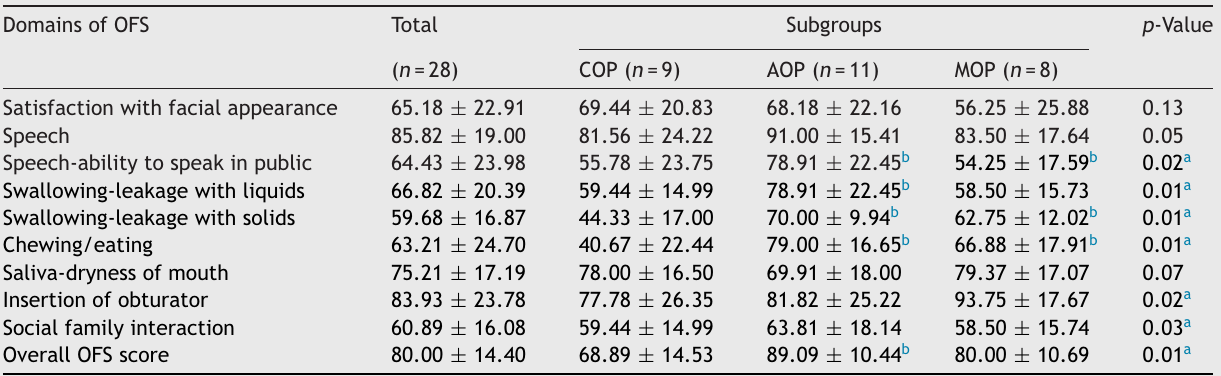
Table 2 Score of OFS questionnaires in